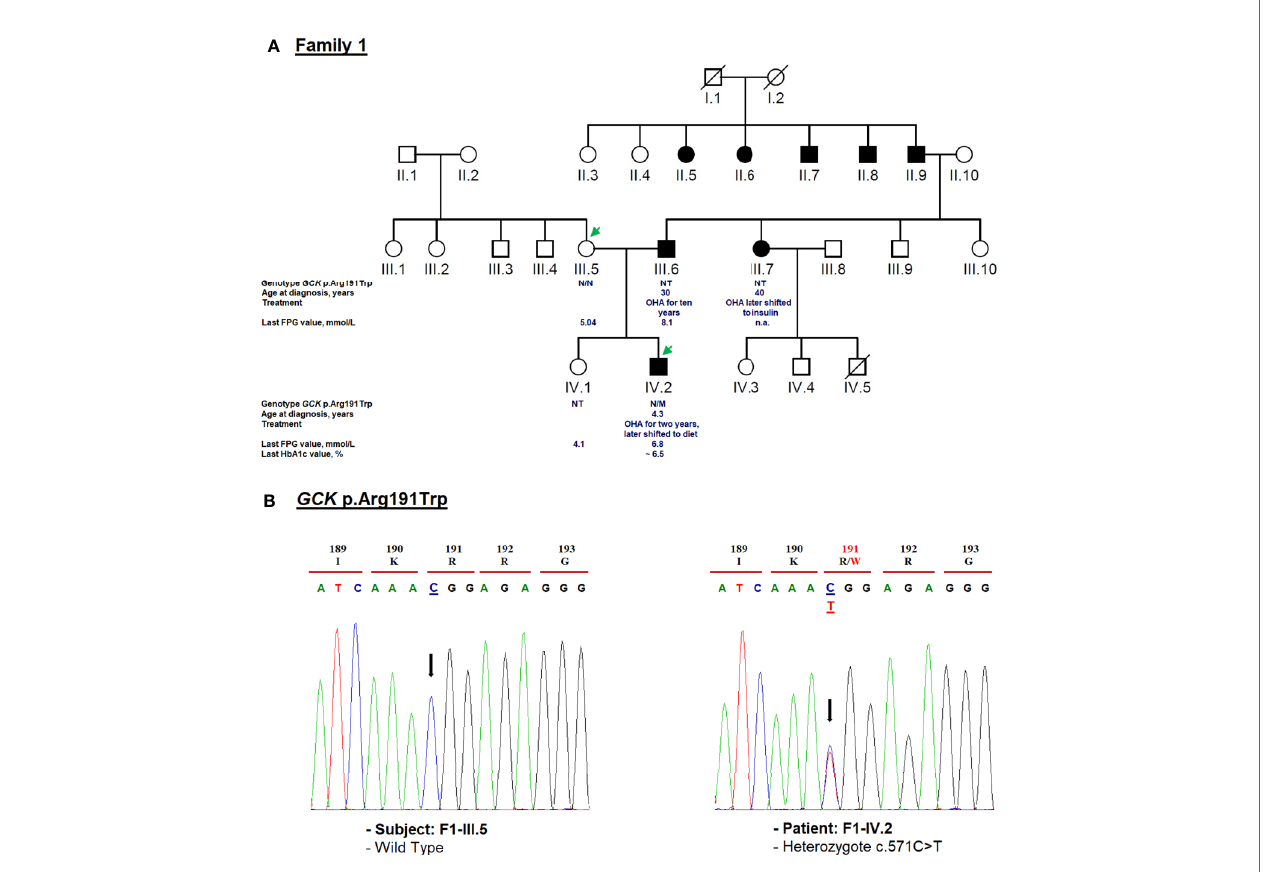
FIGURE 2 | Mutation analysis of the GCK gene. Panel (A) Pedigree of the family F1 identi fi ed with heterozygous GCK variant (NM_000162.5: c.571C>T, p.Arg191Trp). The generations within the family are indicated by roman numerals. Squares and circles represent male and female family members, respectively. Normal individuals are shown as a clear symbol. Black- fi lled symbols denote patients with diabetes. A line through a symbol denotes the deceased. Green arrows indicate available DNA members. OHA, oral hypoglycemic agents; FPG, fasting plasma glucose; NT, not tested. The genotype is shown underneath each symbol. M and N denote mutant and wild-type alleles, respectively. The age of diabetes onset, glycemic control (the latest FPG or HbA1c measurements), and treatment follow- up are indicated directly below the genotype. Panel (B) Electropherogram analysis of GCK gene in the family F1. Mutated nucleotide on the chromatographs is depicted with an arrow. Amino acid substitution is indicated in